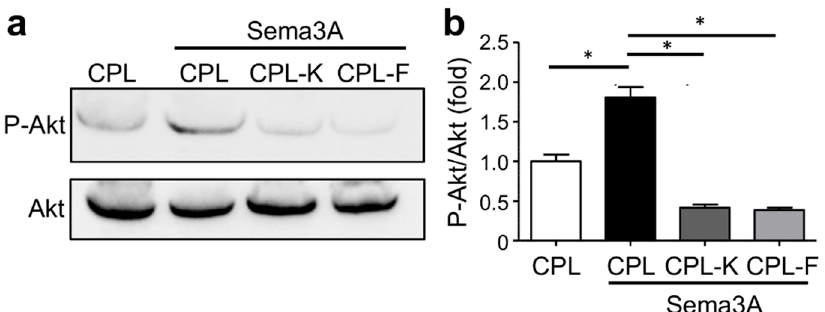
Figure 6. CPL-K and CPL-F inhibit Sema3A-induced Akt phosphorylation. ( a , b ) Representative Western blot ( a ) and quantification of Western blot signals ( b ) of Akt and P-Akt in MDA-MB-231 cells upon stimulation with Sema3A. Note that Sema3A-induced P-Akt levels are suppressed by CPL-K and CPL-F but not by CPL. N = 3 experiments. * p < 0.05 (one-way ANOVA and Dunn multiple comparison